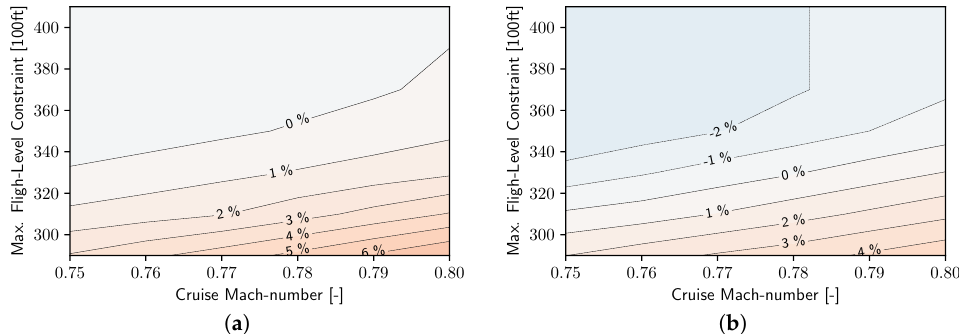
Figure 11. MTOM difference for PtL concept D261+SAF ( a ) and LH2 concept D261+H2 ( b ).